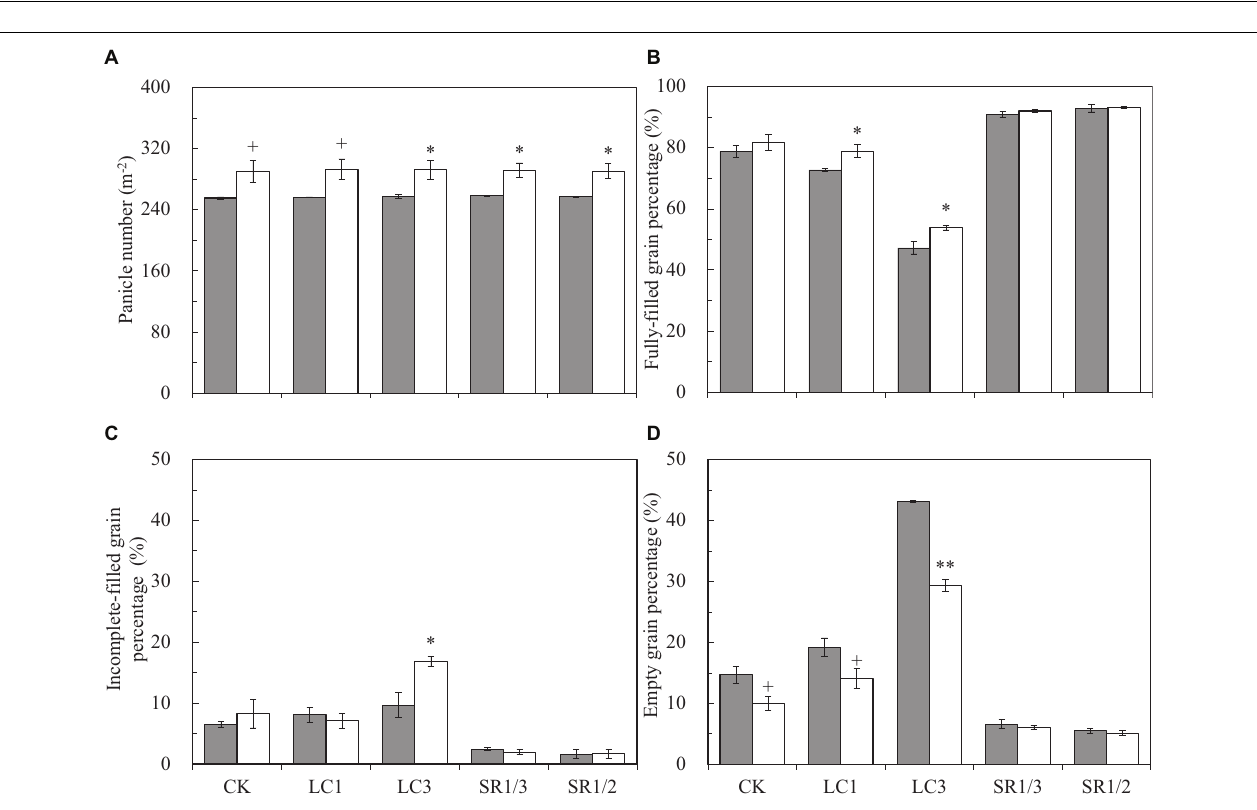
FIGURE 1 | Grain yield per area (A) and grain yield per panicle (B) of WYJ27 affected by elevated CO 2 and different source-sink treatments in 2017. Each bar in the figure represents the mean values across three plots for ambient CO 2 (aCO 2 , filled square) or elevated CO 2 (eCO 2 , aCO 2 + 200 ppm, unfilled square); vertical bars represent standard error ( n = 3). CK, no leaf cutting or spikelet removing; LC1, cutting off the flag leaf; LC3, cutting off top three leaves; SR1/3, removing one branch in every three branches of a panicle; SR1/2, removing one branch in every two branches of a panicle. ** P < 0.01, * P < 0.05, + P < 0.1.